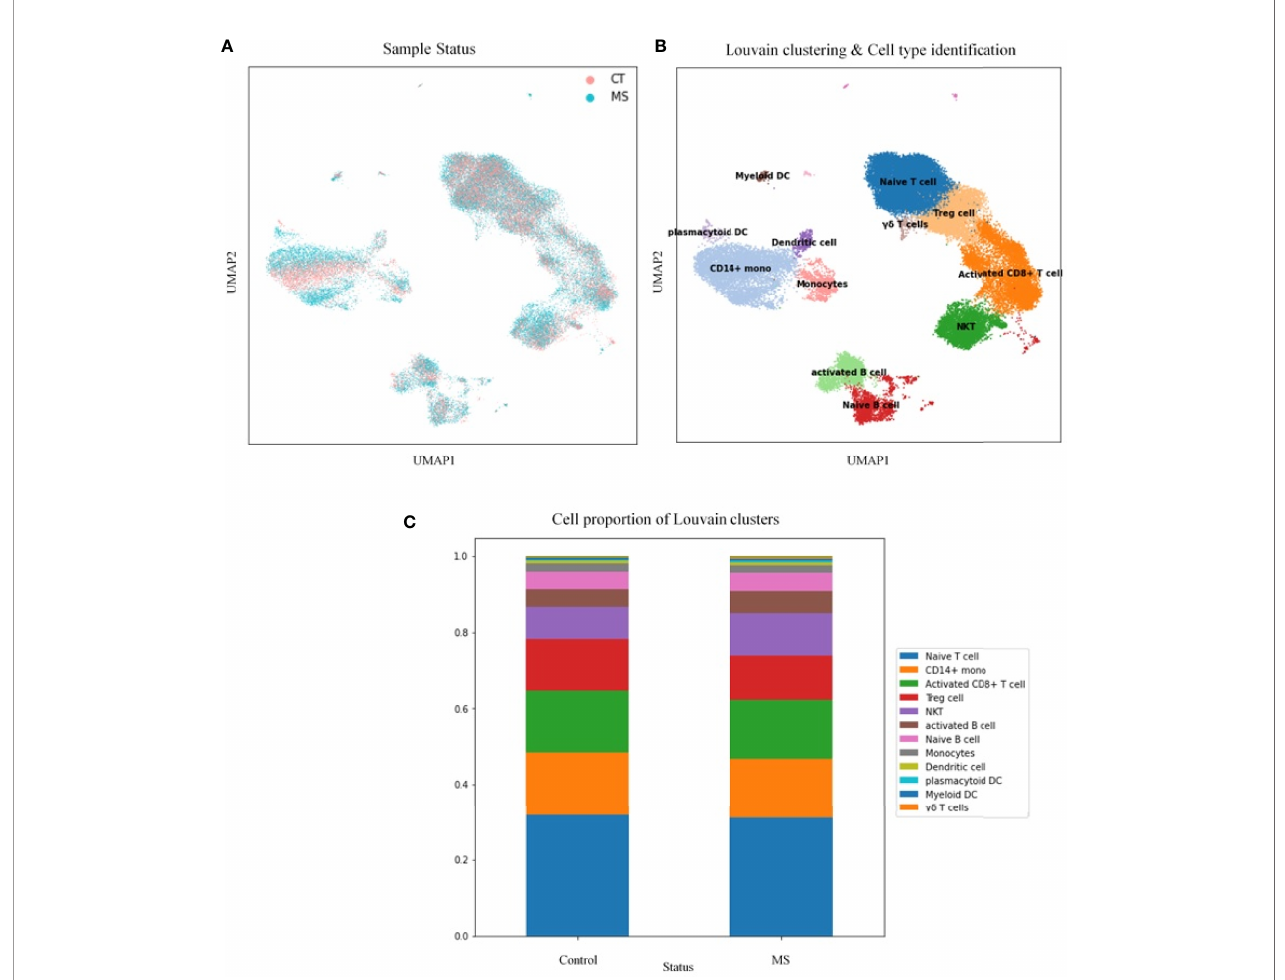
FIGURE 6 | Transcriptomic comparison of MS versus control PBMCs. (A) UMAP projection of cells with the normal situation (n=17138) colored in dark blue and cells from MS samples (n=25831) were visualized in light blue. (B) Louvain clustering and cell annotation was employed to identify 12 major cell populations. (C) Bar graphs quantify and compare the proportion of single-cell data of control and MS